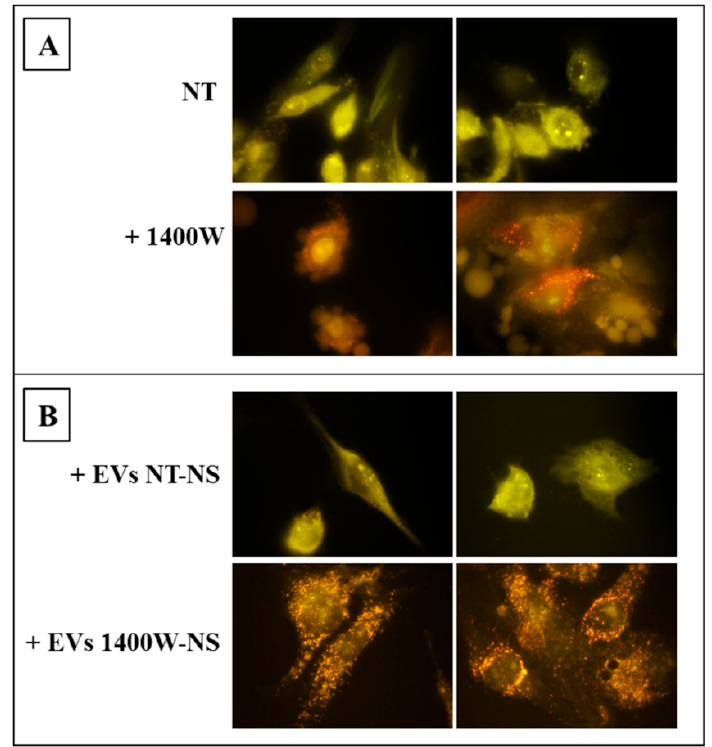
Figure 8. Induction of autophagy by 1400W in adherent U87MG cells. ( A ) U87MG cells were treated or not with 1400W (100 µ M) for 48 h and then stained with AO to assess the content of acidic vacuoles (orange / red spots) by fluorescence microscopy. Two images for each condition are shown (magnification 100 × ) and are representative of two independent experiments. ( B ) U87MG cells were treated for 48 h with EVs derived from NT (EVs NT-NS) and 1400W-treated (EVs 1400W-NS) NS. After treatment cells were stained as above described. Also in this case, two images for each condition are shown and are representative of two independent experiments.